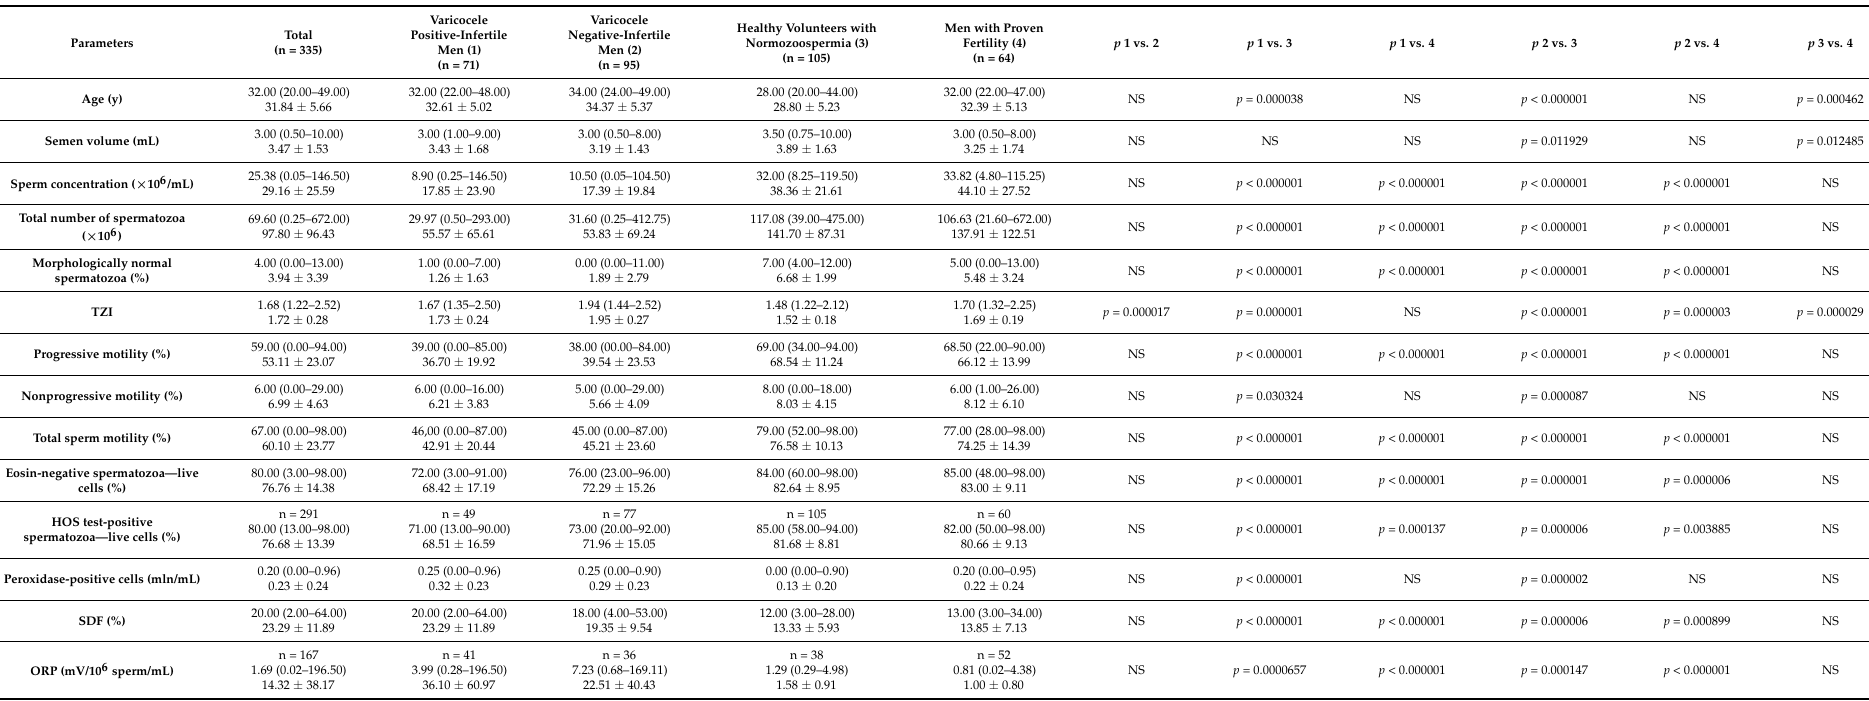
Table 1. Descriptive statistics and comparisons of age, standard semen parameters, SDF and ORP between study